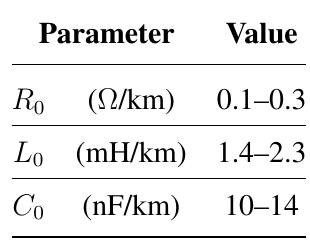
Table 1. The parameters of the electrical